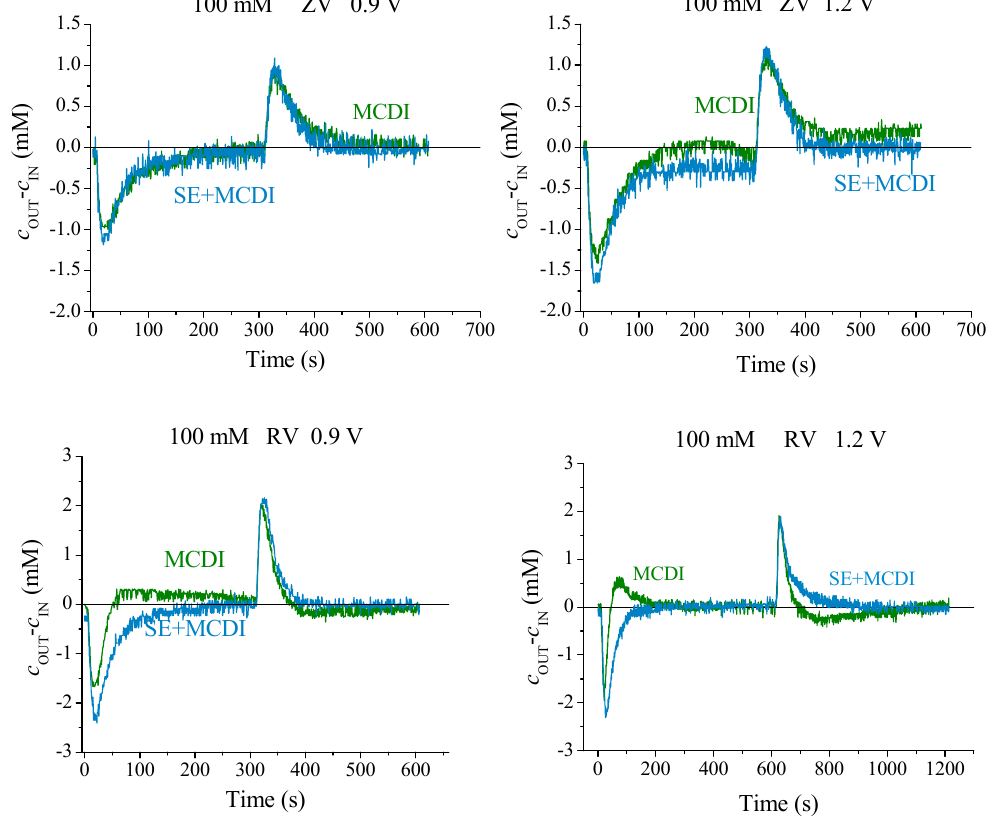
Figure 5. Capacitive deionization (CDI) cycles for 100 mM NaCl solutions, using MCDI and SE + MCDI, set to ZV ( top ) and RV ( bottom ) desorption mode.